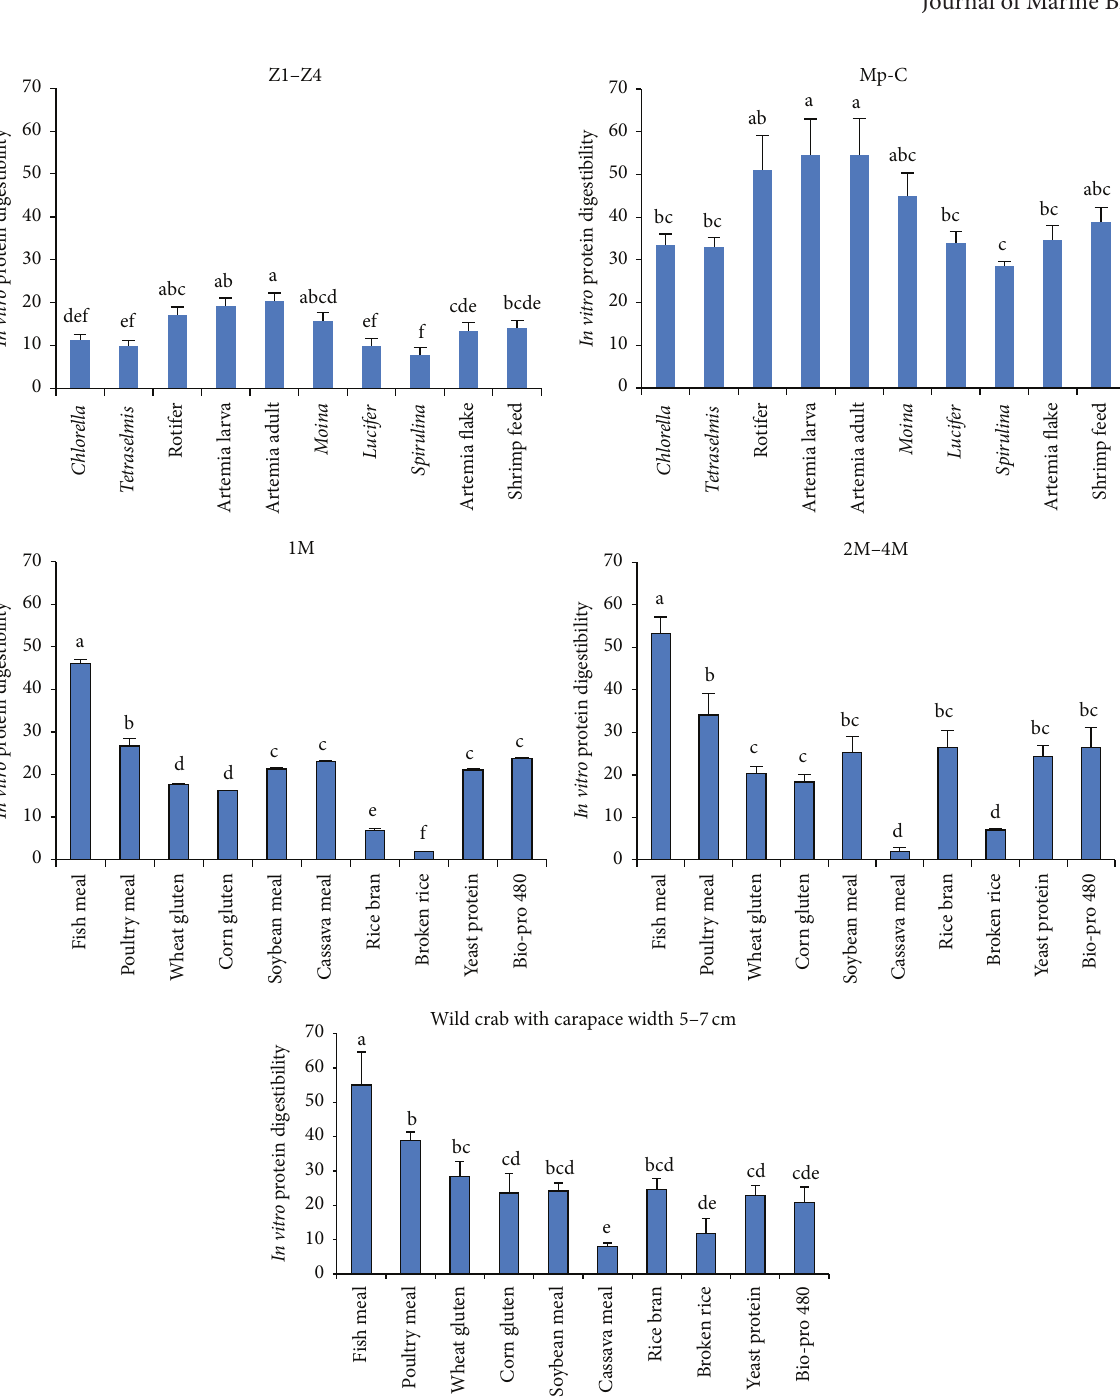
are the most suitable diets for these early stages of P . pelagicus ,